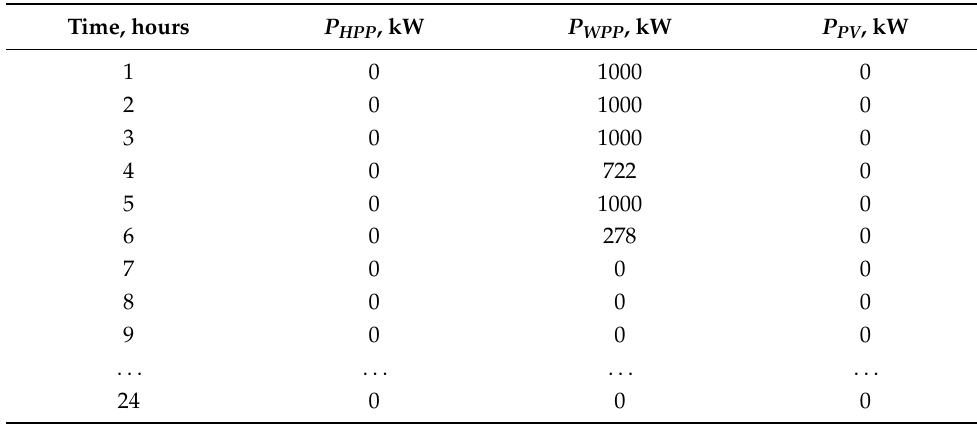
Table 2. An accumulation of a power energy from various generation